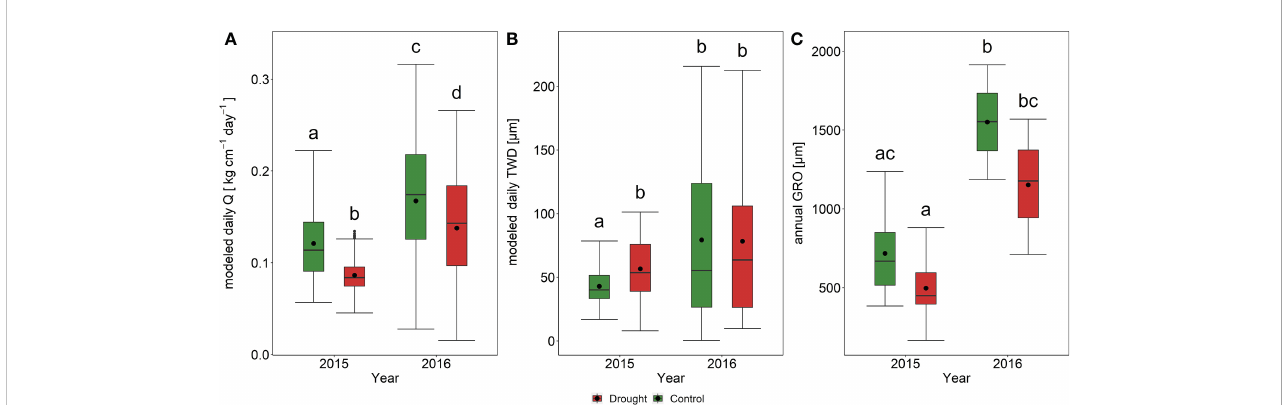
FIGURE 4 Boxplots for values of modelled speci fi c sap fl ow - Q (A) , modelled tree water de fi cit - TWD (B) , and annual values of radial growth - GRO (C) . The data are expressed as medians (solid lines) and means (dots) of measured modeled values. The box boundaries mark the 25th and 75th percentiles, and the whiskers show the minimum and the maximum. Different letters indicate the statistically signi fi cant variation between the group means. The modeled values are derived from ARIMA